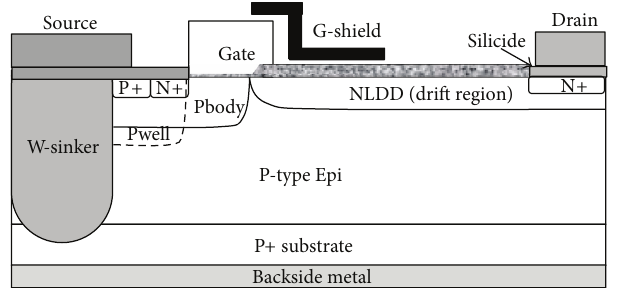
Figure 1: The proposed W-sinker RF LDMOS device structure.